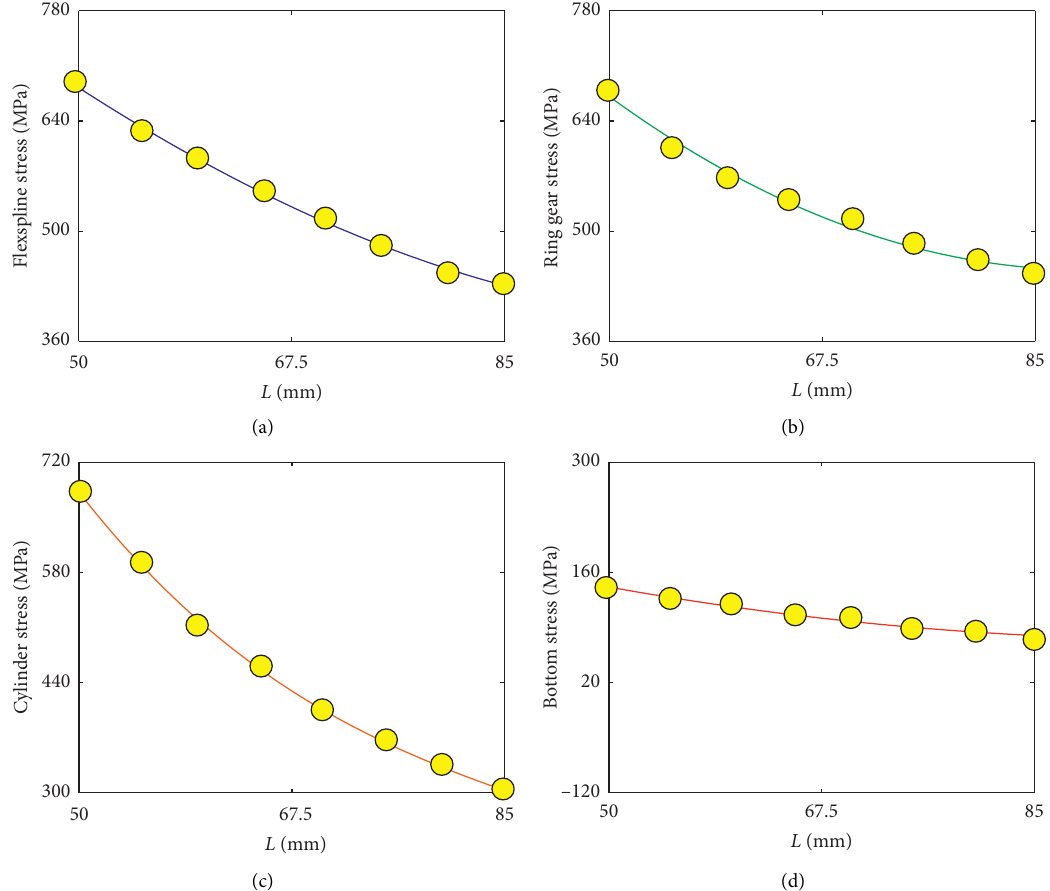
Figure 12: Stress influence curve of different round length flexsplines. (a) Flexspline stress. (b) Ring gear stress. (c) Cylinder stress. (d) Bottom